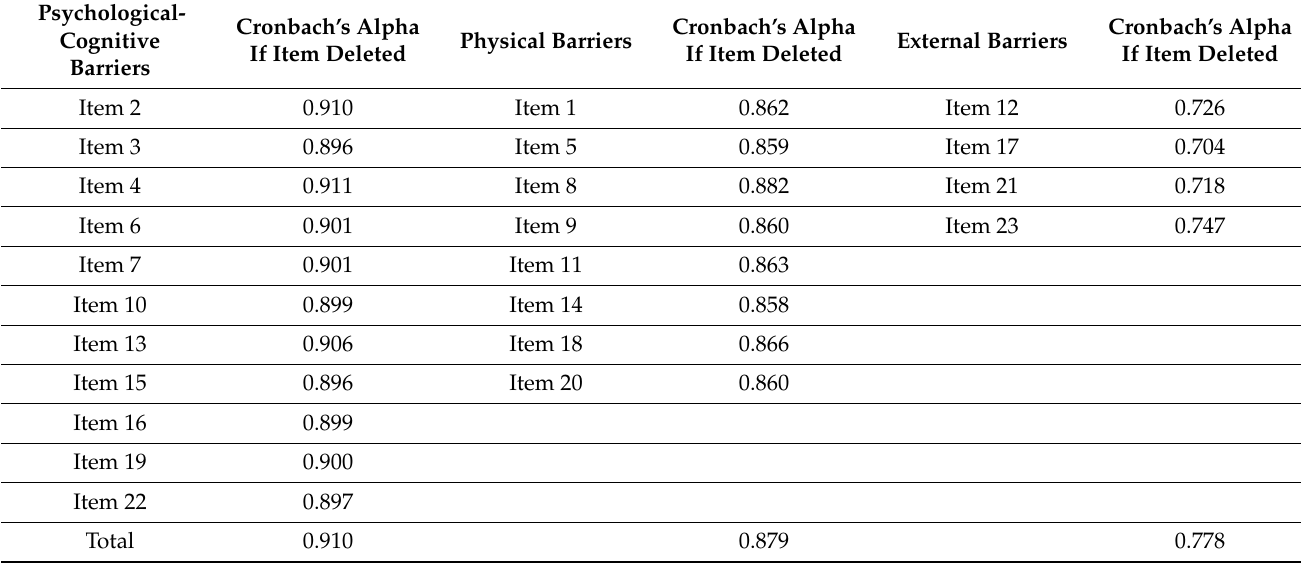
Table 5. Cronbach’s alpha if item deleted for the MSWDQ-23